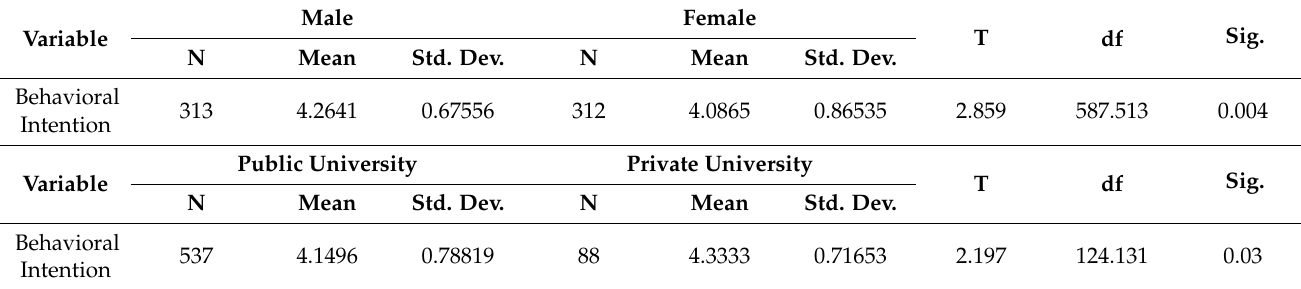
Table 8. T -test of the respondent behavioral intention attributed to